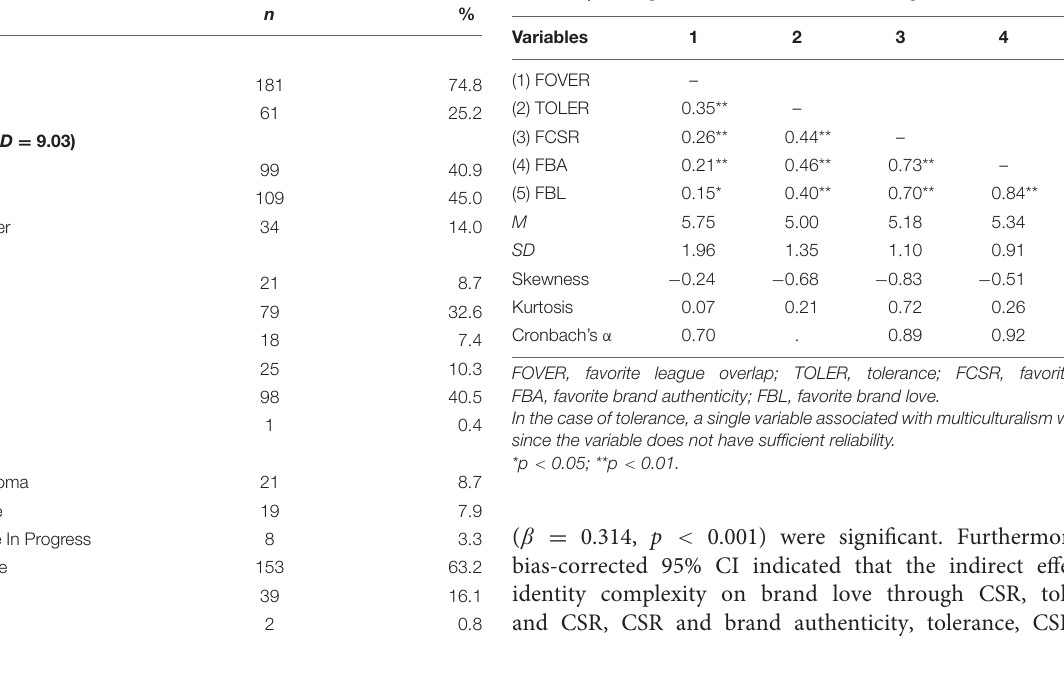
TABLE 3 | Rankings for favorite and least favorite